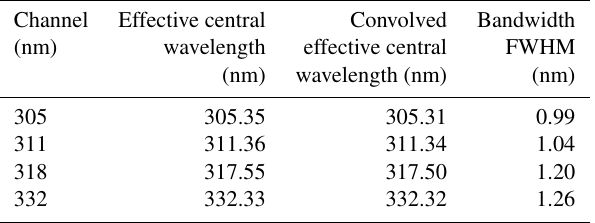
Table 1. Wavelength characteristics of UVPFR no. 1001 based on laboratory measurements in February 2016. The third column shows effective central wavelength resulting from convolving the spectral response function with an extraterrestrial solar spectrum.